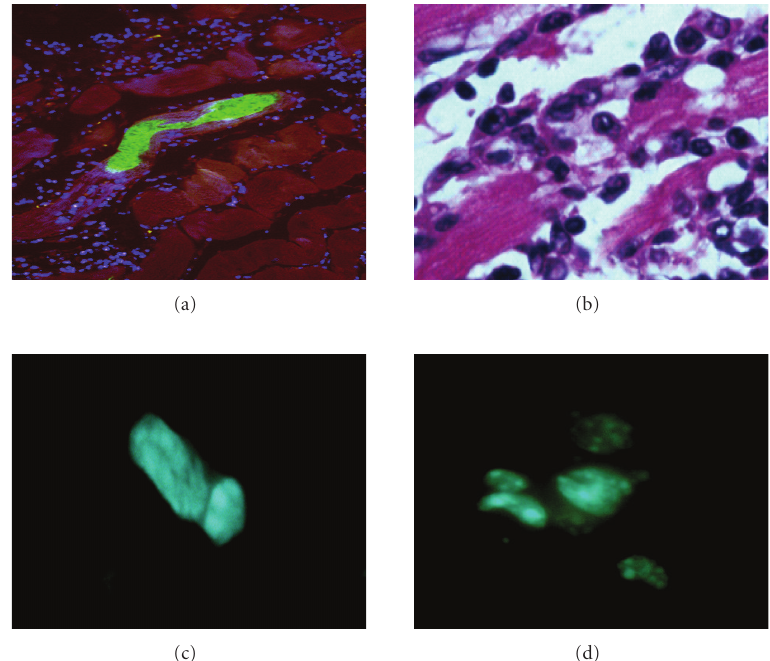
Figure 1: Heart sections of T. cruzi -infected mice. (a) BALB/c mouse during the acute phase of infection with Colombian strain T. cruzi , showing a parasite nest (green), DAPI-stained nuclei (blue) and myofibers (red). The majority of the DAPI nuclei belong to inflammatory cells that infiltrate the heart in areas infected with parasites. (b) Inflammation of chronic chagasic BALB/c mouse, showing inflammatory cells adhered to myofibers causing myocytolysis. (c) and (d), Detection of bone marrow stem cells (BMC) in the myocardium of chronic chagasic mice. BMC obtained from normal BALB/c mice were injected i.v. into chronic chagasic mice (18 months of infection). BMC were incubated with the fluorescent DNA stain Hoechst 33258 prior to injection into chagasic mice. Sections of frozen heart fragments were prepared 7 (c) and 15 (d) days after BMC injection and fixed with cold acetone. Sections were observed in an Olympus spectral confocal microscope FV1000 observed by fluorescence microscopy. In chagasic mice Hoechst + cells could be observed 1–7 days after BMC injection, some of which were already beginning cell division cycles (c). Hoechst + cells proliferated and formed clusters of cells bearing a dotted nuclear fluorescent pattern that could be observed up to 30 days after BMC transplant